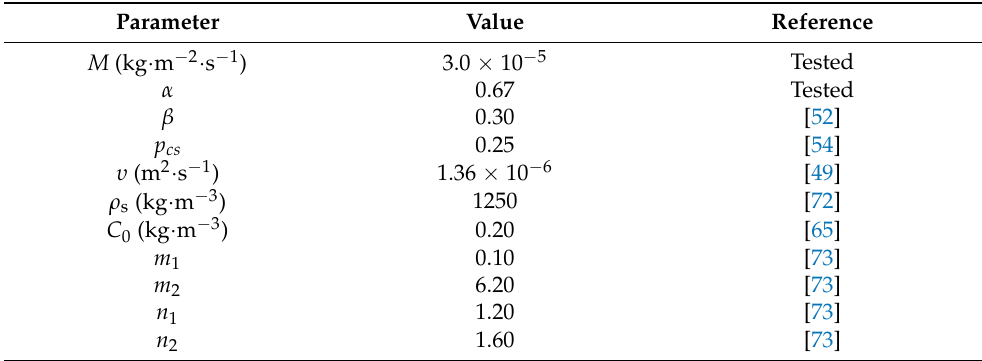
Table 1. Parameters in the sediment